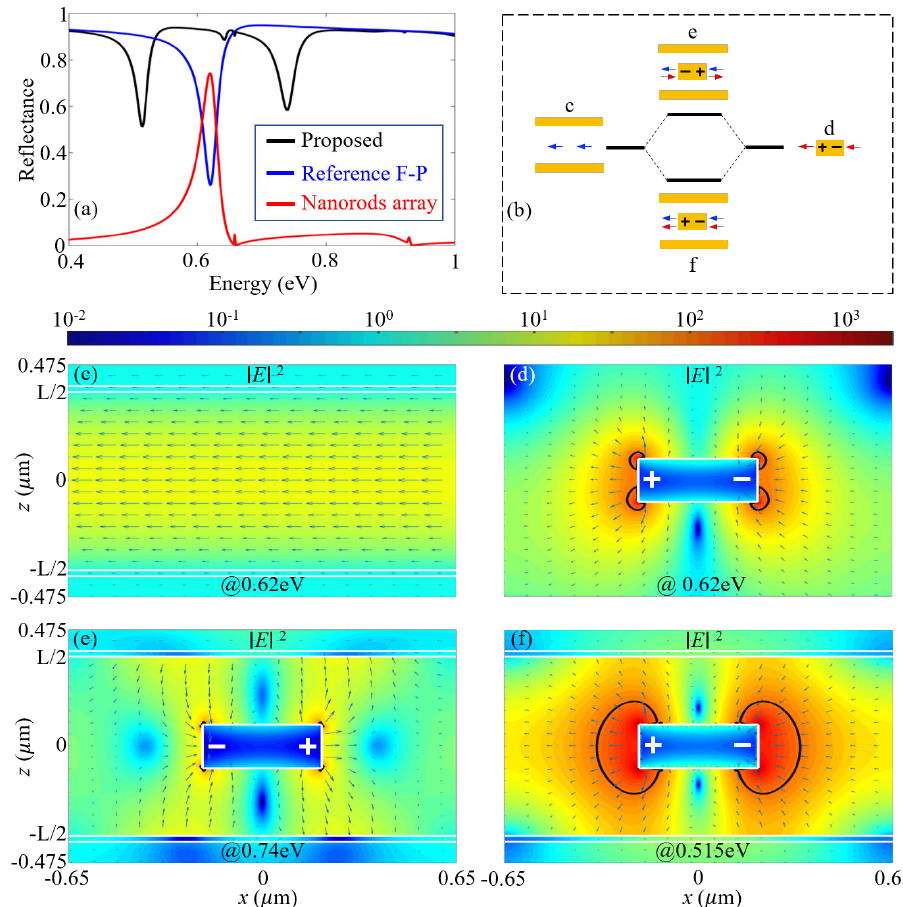
Figure 3. ( a ) Simulated reflectance spectra of the proposed plasmonic–photonic system (black curve), the reference F-P cavity (blue curve) and the nanorods array (red curve). The calculations were performed with L = 765 nm. ( b ) Schematic illustration of the strong coupling of the first-order F-P resonance and the SLR into a bonding and an antibonding mode. The arrows indicate the directions of the near-field electric fields. ( c – f ) Simulated electric field distributions | E | 2 (color for intensity and arrows for directions) in the unit cell of ( c ) the reference first-order F-P resonance, ( d ) of the SLR of the nanorods array at 0.62 eV, and ( e , f ) of the split modes of the proposed structure that are resonant at ( e ) 0.74 eV and ( f ) 0.515 eV. The nanorods array and the thin metal films are outlined by white lines. “+” and “ − ” in ( d – f ) indicate charge distributions. The black curves in ( d – f ) show contours for electric field intensity enhancement of